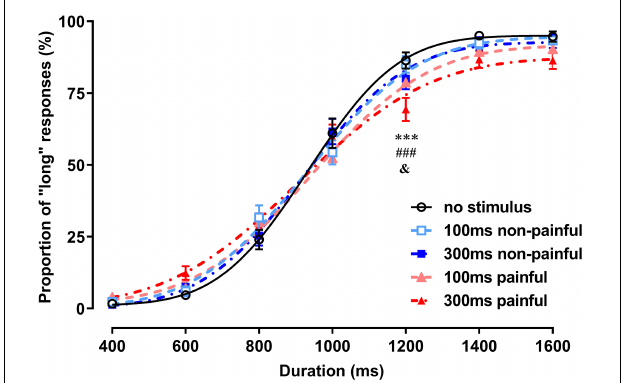
FIGURE 2 | Proportions of long responses and fitting curves for the five sessions of the temporal bisection task. *** P < 0.001, 300-ms painful vs. no stimulus; ### P < 0.001, 300-ms painful vs. 100-ms non-painful; & P < 0.05, 300-ms painful vs. 300-ms